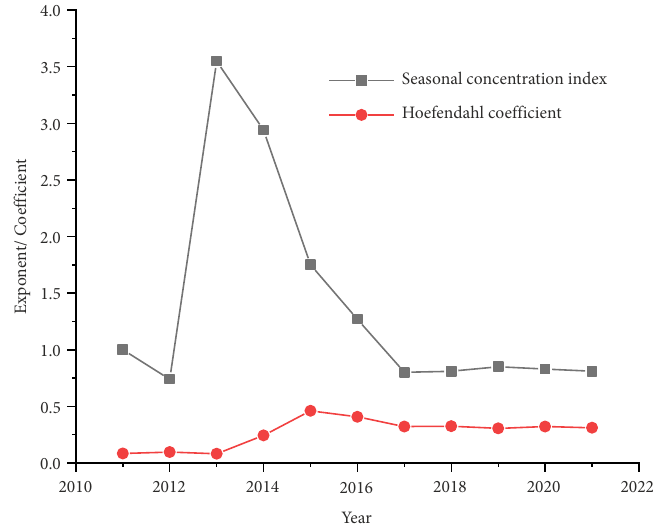
Figure 8. Seasonal concentration index and Hafendar coefficient